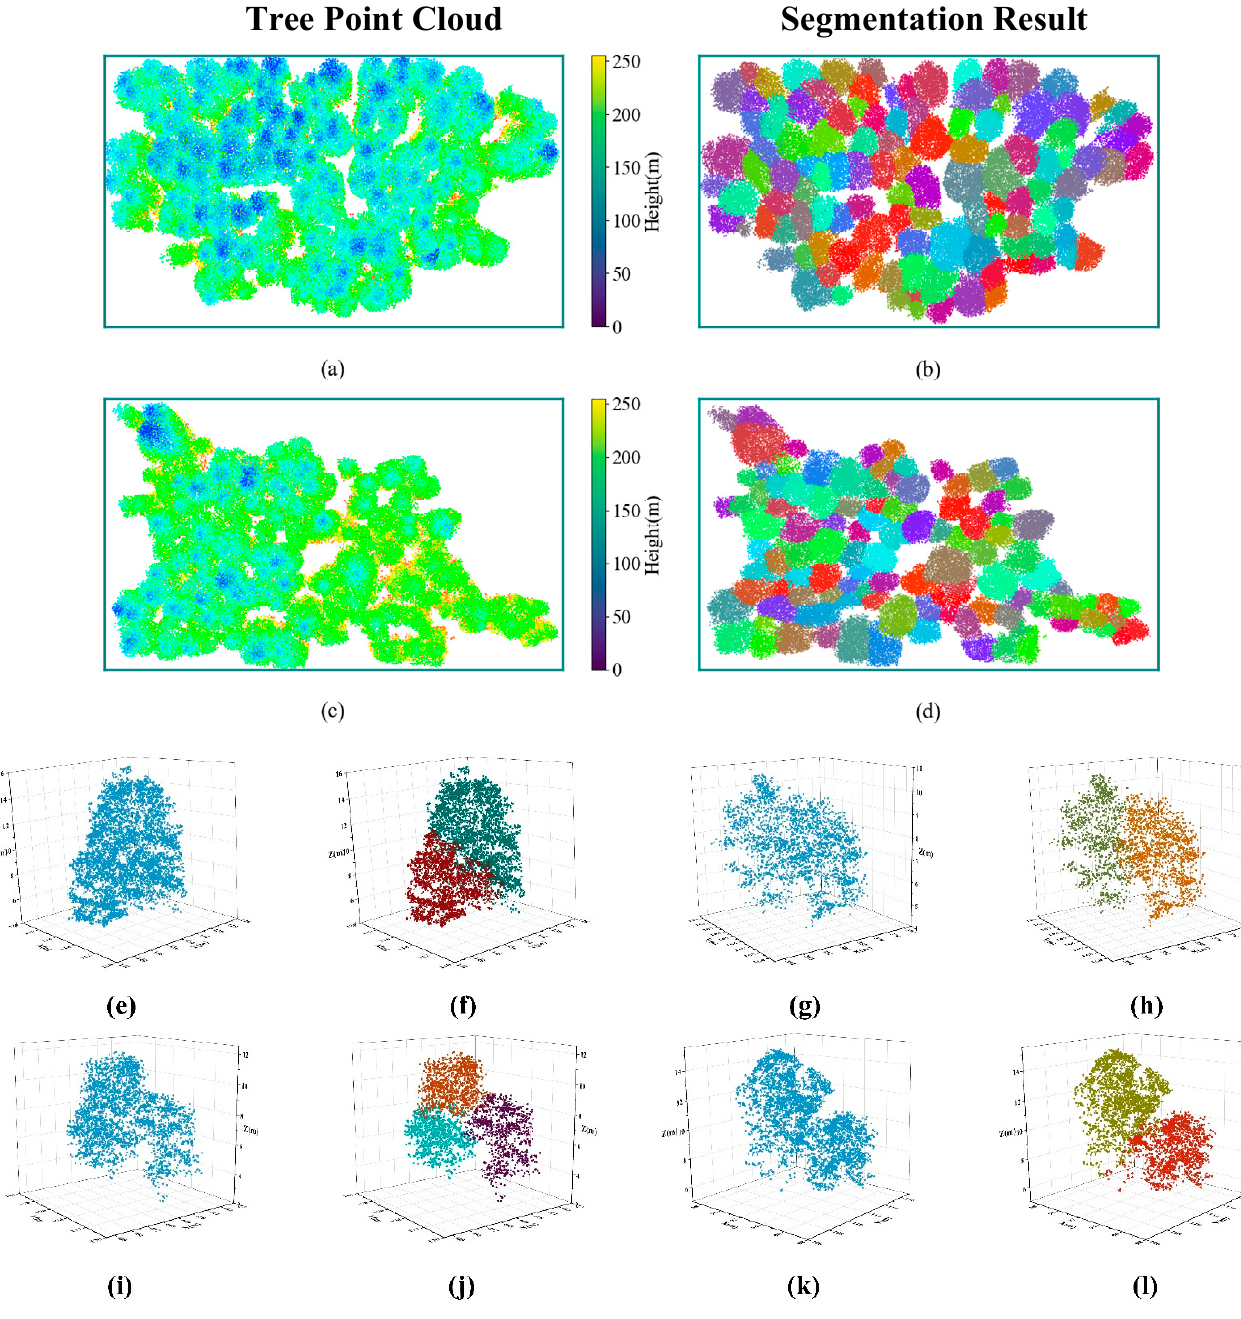
Figure 10. ( a – d ) MS+GMM-optimized segmentation results for some samples; ( e – l ) Normal segmen- tation results obtained after GMM-optimized segmentation for some under-segmented samples after segmentation by the MS algorithm.